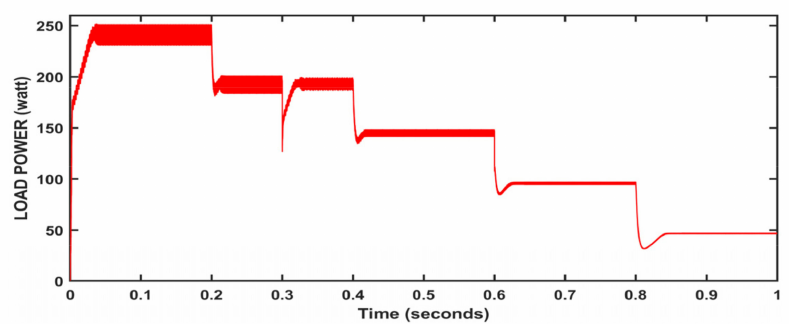
Figure 9. Algorithm performance at constant atmospheric conditions; T = 25 ◦ C, w = 1000 W/m 2 , R = 10 Ω .